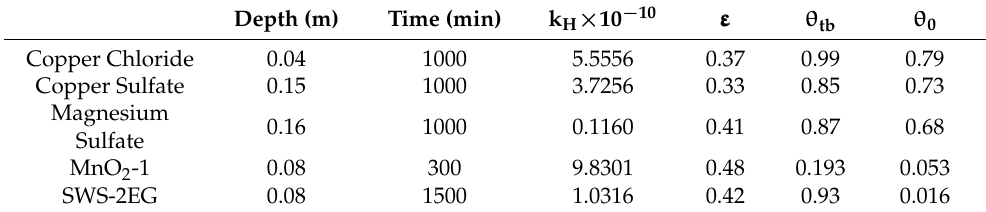
Table 3. Materials